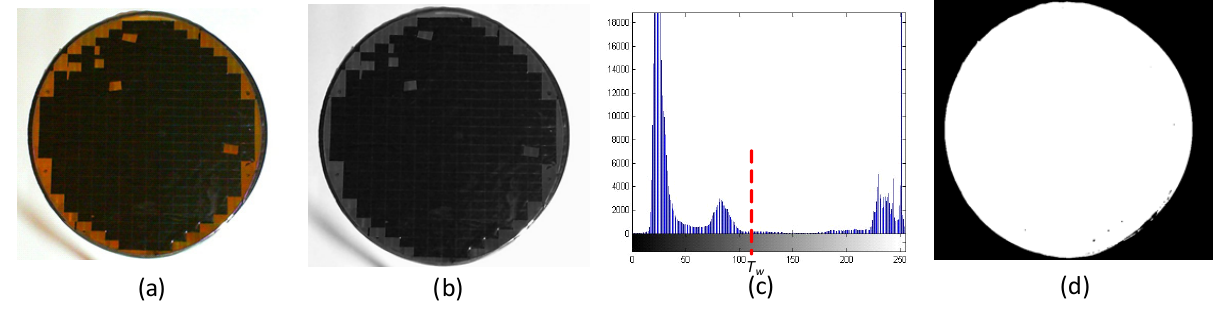
Figure 2. ( a ) Original image; ( b ) grayscale image; ( c ) histogram of the grayscale image; ( d ) binarized